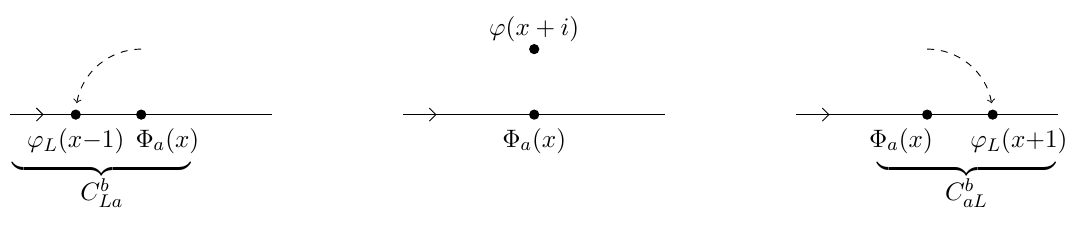
Figure 3 . The relation between C b